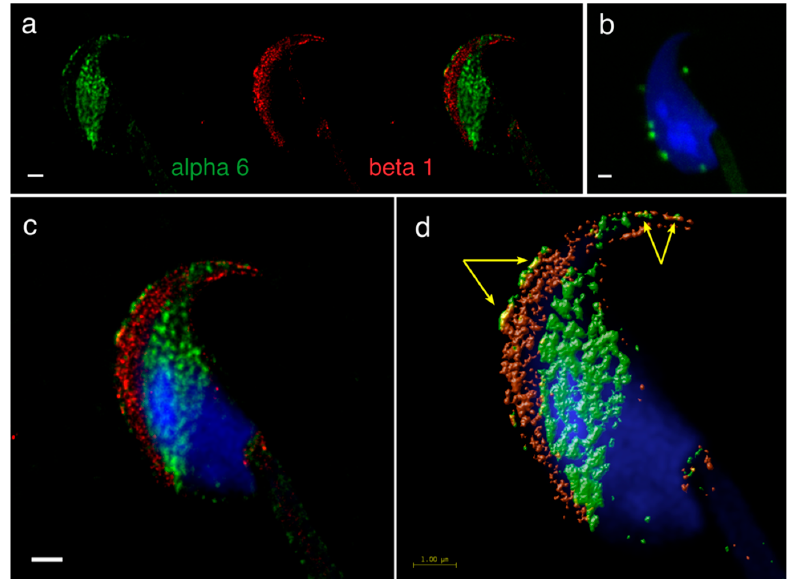
Figure 4. Mutual localization of α 3 and β 1 integrin subunit and a presence of α 3 β 1 heterodimer revealed by SIM and PLA. ( a ) α 3 (green) and β 1 (red) are localized in the acrosomal cap area of intact sperm head, ( b ) PLA confirmed a presence of the α 3 β 1 heterodimer. ( c ) SIM depicted their mutual localization in same structures. ( d ) Huygens software was used for better visualization of colocalization area (yellow) of α 3 and β 1. Colocalization maps are based on Pearson’s correlation coefficient. Nucleus is visualized with Dapi (blue). Scale bar represents 1 µ m ( a – c ) and 2 µ m ( d ).